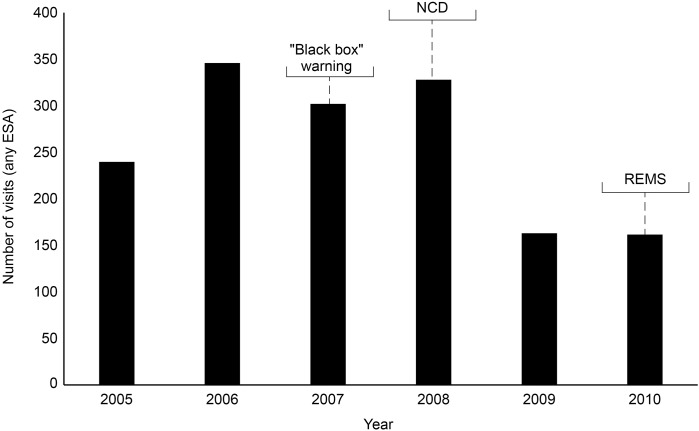
Electronic health records in Cerner Database: overall annual trend in the number of visits with ESA use per reporting hospital. The number of cases for which an ESA was prescribed increased 44% from 240 in 2005 to 346 in 2006. ESA use decreased 13% in 2007 from the previous year; then use increased by 9% to 328 cases in 2008. The largest reduction was seen in 2009 with a 50% reduction from 2008. Use remained low from then through 2010. ESA, erythropoiesis-stimulating agent; NCD, National Coverage Determination; REMS, Risk Evaluation and Mitigation Strategy.